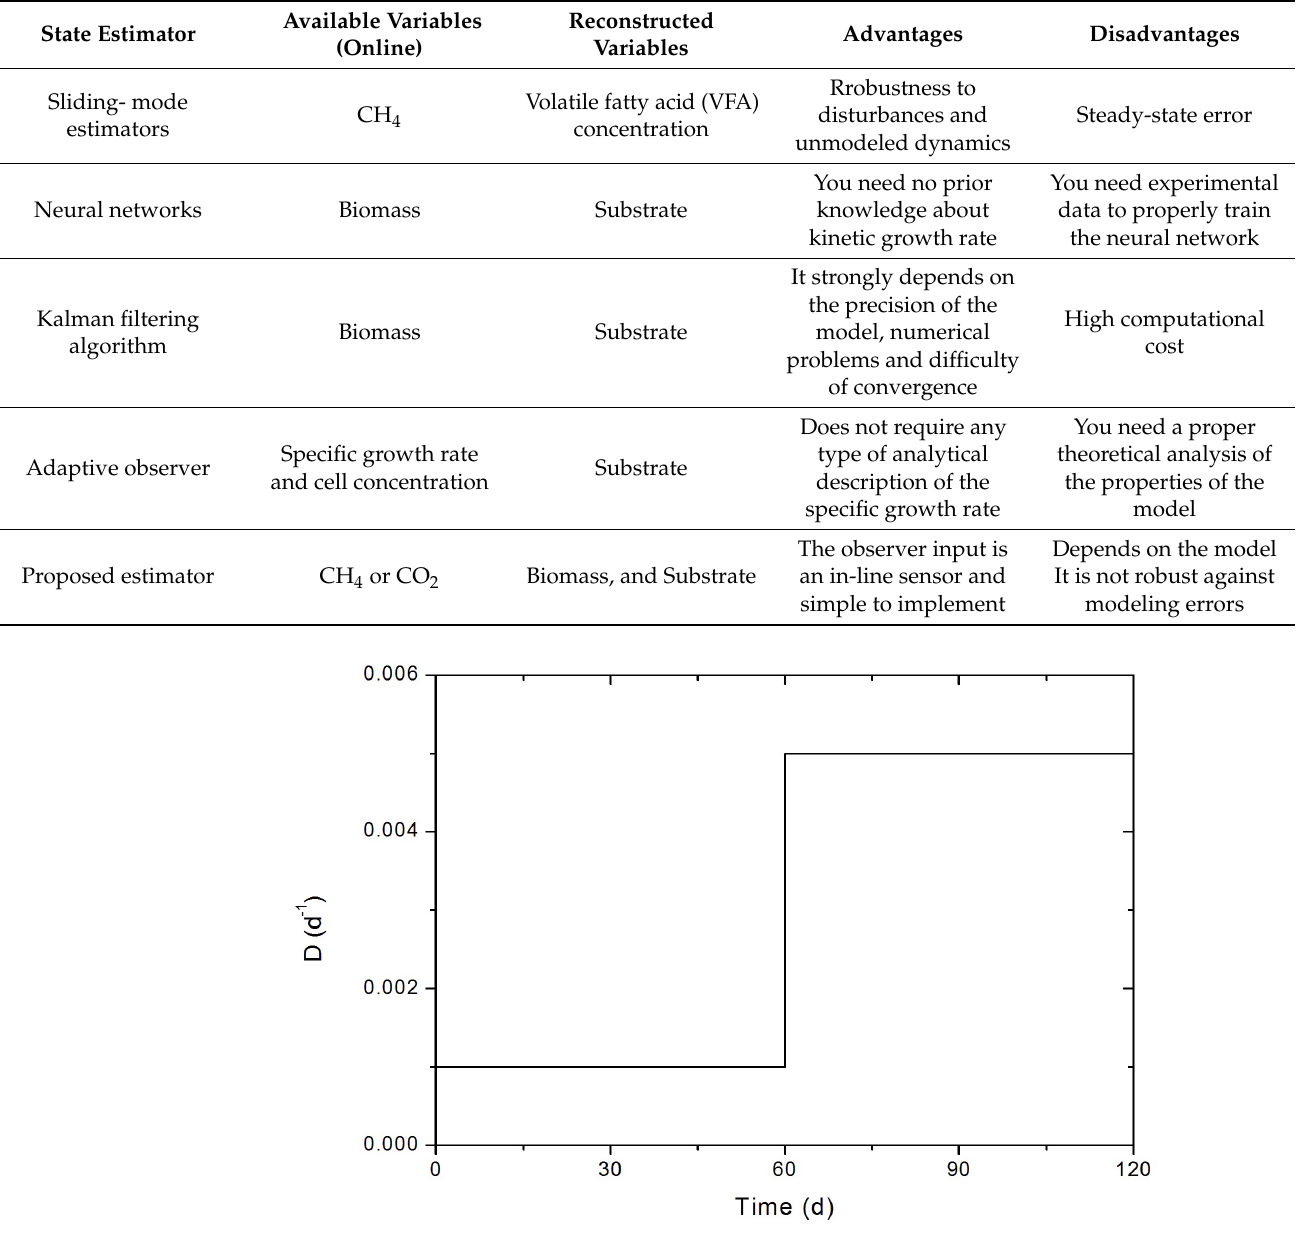
Table 3. Comparison of estimation methods applied in AD processes [37–44].